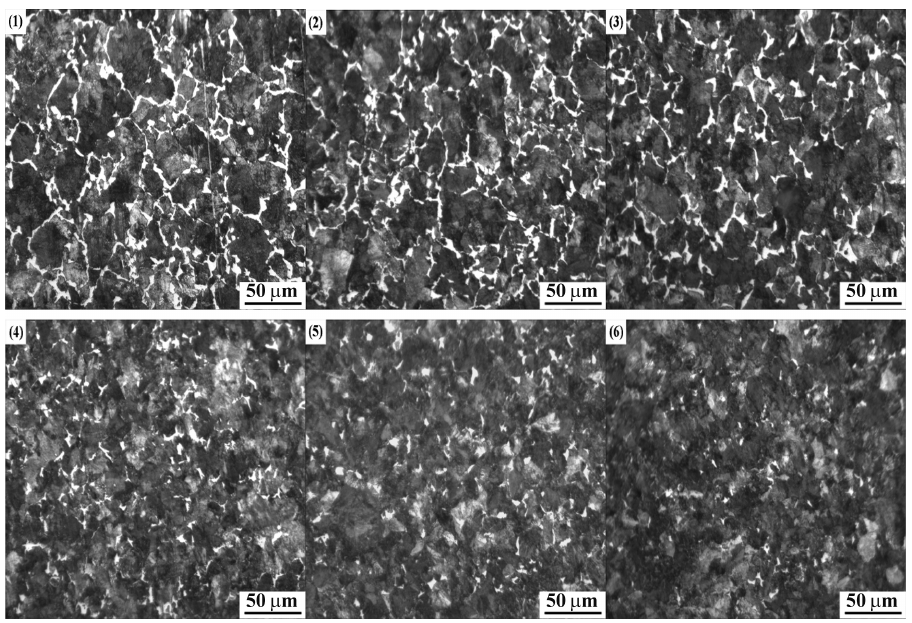
Figure 3: Microstructures of the samples at different cooling rates: (1) 0.5, (2) 1, (3) 2, (4) 3, (5) 4 and (6) 5 °C/s.